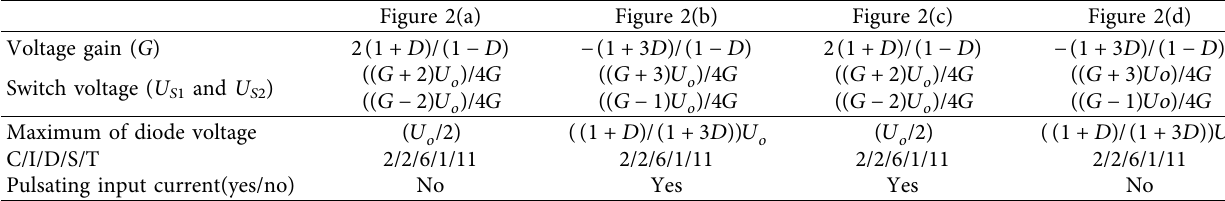
Table 1: Characteristics of the proposed